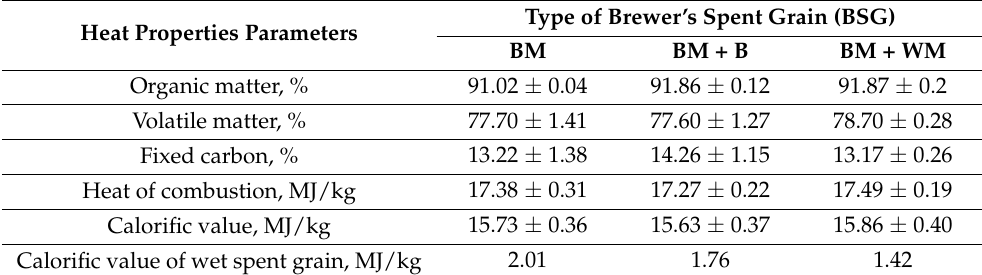
Table 3. Calorific value and other energy parameters of brewer’s spent grain (dry basis).